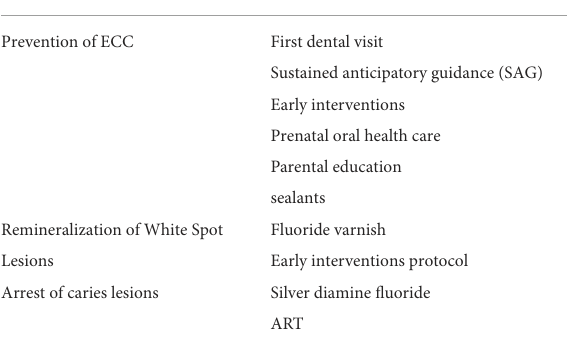
TABLE 2 SDG targets of ECC and their